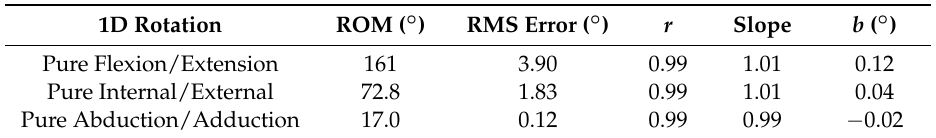
Table 1. Quantitative comparisons for cases of pure rotation about a single axis including range of motion (ROM), RMS error, correlation ( r ), and slope and y-intercept ( b ) of linear fit.